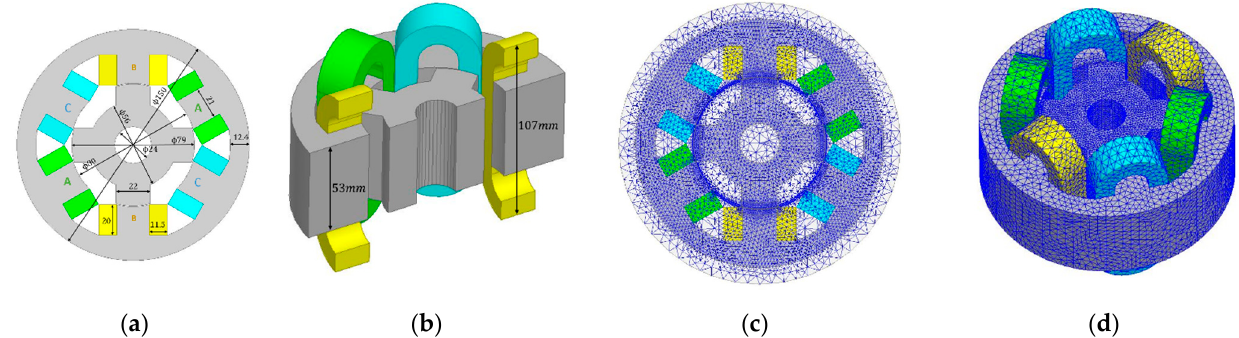
Figure 4. ( a , b ) 2D and 3D SRM design schemes with the geometrical parameters and basic layout of the FEM model: ( c ) 2D mesh model and ( d ) 3D mesh model. Table 2. Mean torque, torque ripple, and relative errors between 2D and 3D